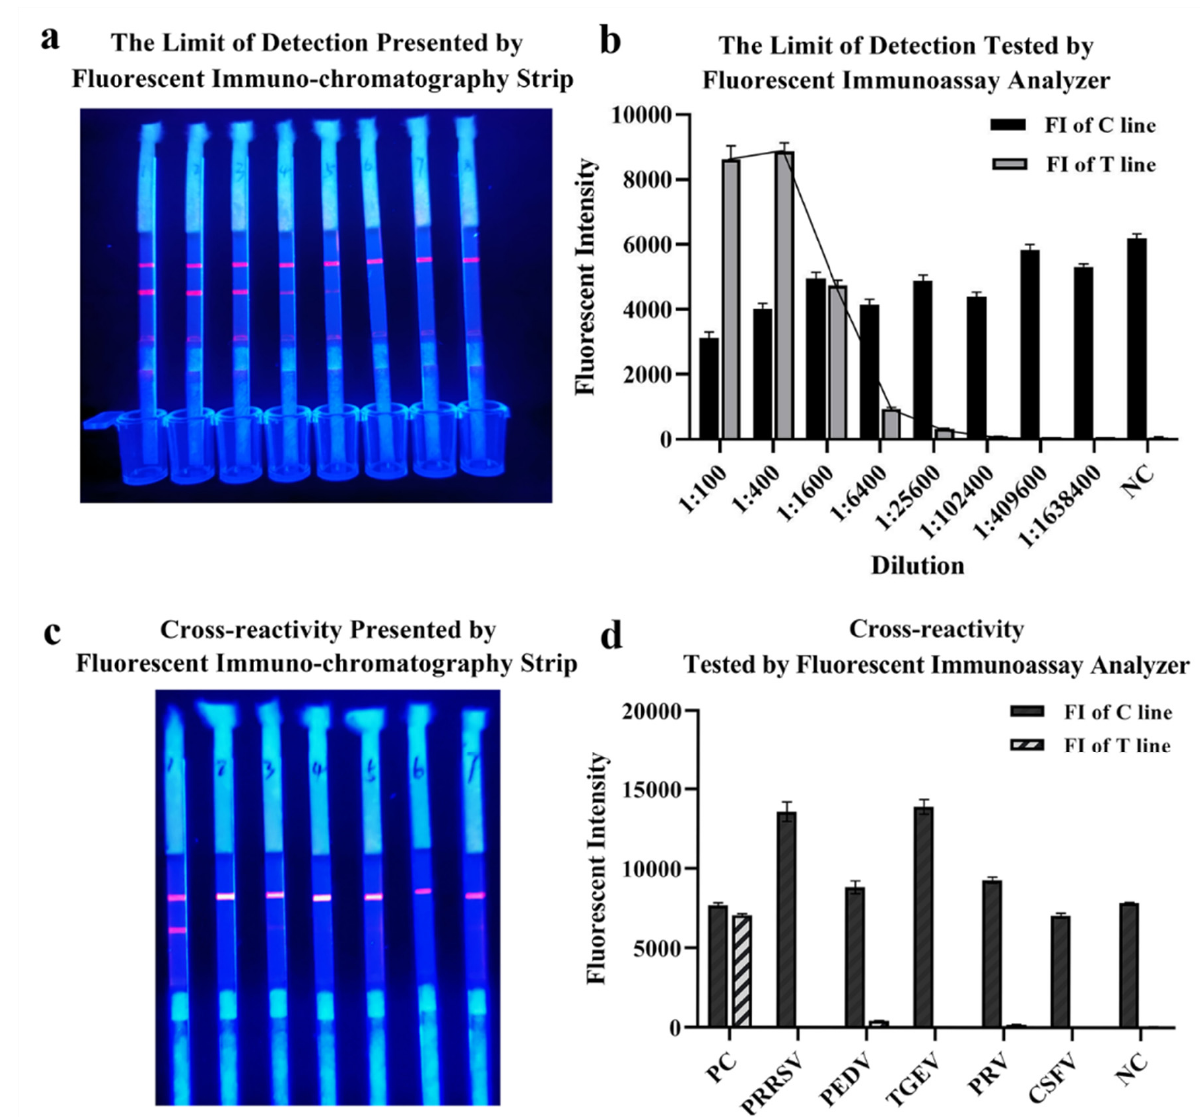
Figure 5. The limit of detection and cross-reactivity of the lateral flow assay. ( a , b ) The limit of detection of the lateral flow assay. ( c , d ) Cross-reactivity with other coronaviruses and respiratory-infection-related viruses ( n = 5).